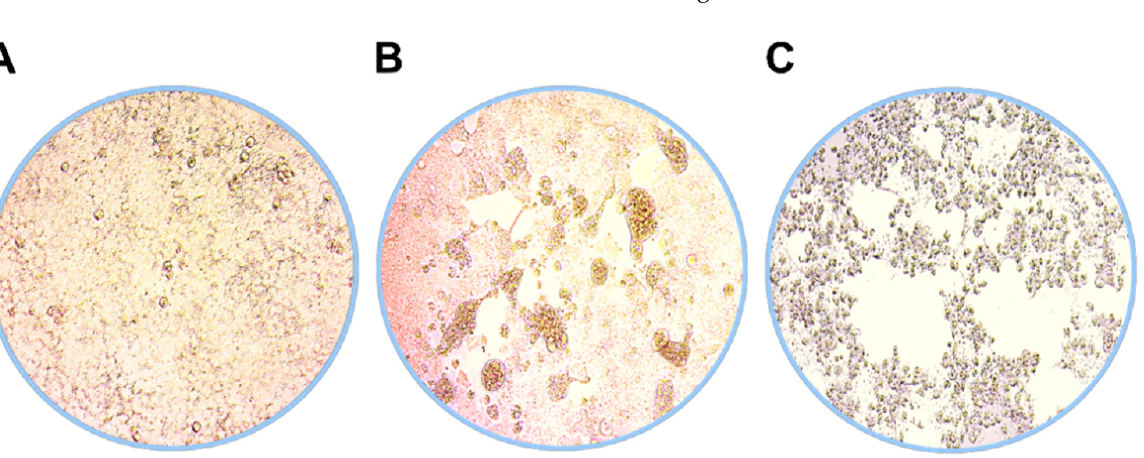
Figure 1. Examples of cell morphology 5 days p.i. in ( A ) uninfected, ( B ) SARS-CoV-2 B.1.1.7, and ( C ) SARS-CoV-2 B.1.351 infected Vero E6 cells representing healthy, low-level CPE with enlarged cells and advanced CPE cultures, respectively.